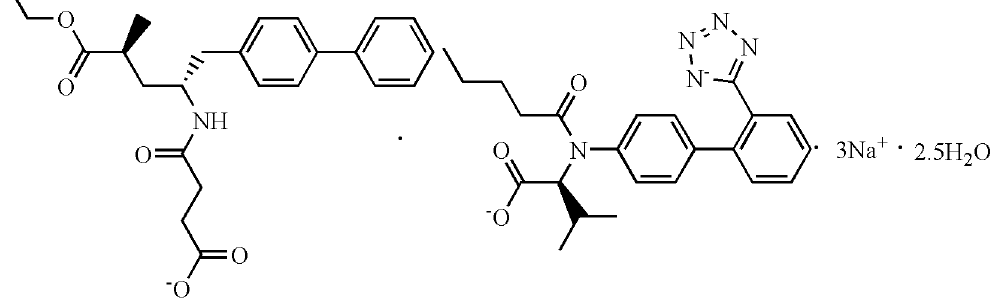
Figure 2. Chemical structure of LCZ696.